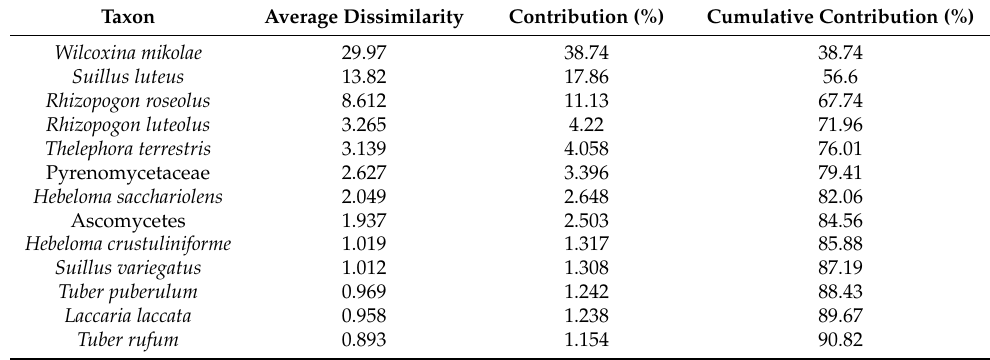
Table 3. Similarity of percentages (SIMPER) output indicating the percentage of contribution of ecto- mycorrhizal to 1- and 2-year-old Scots pine seedlings in forest bare-root nurseries (an accumulative contribution to 90% is presented).